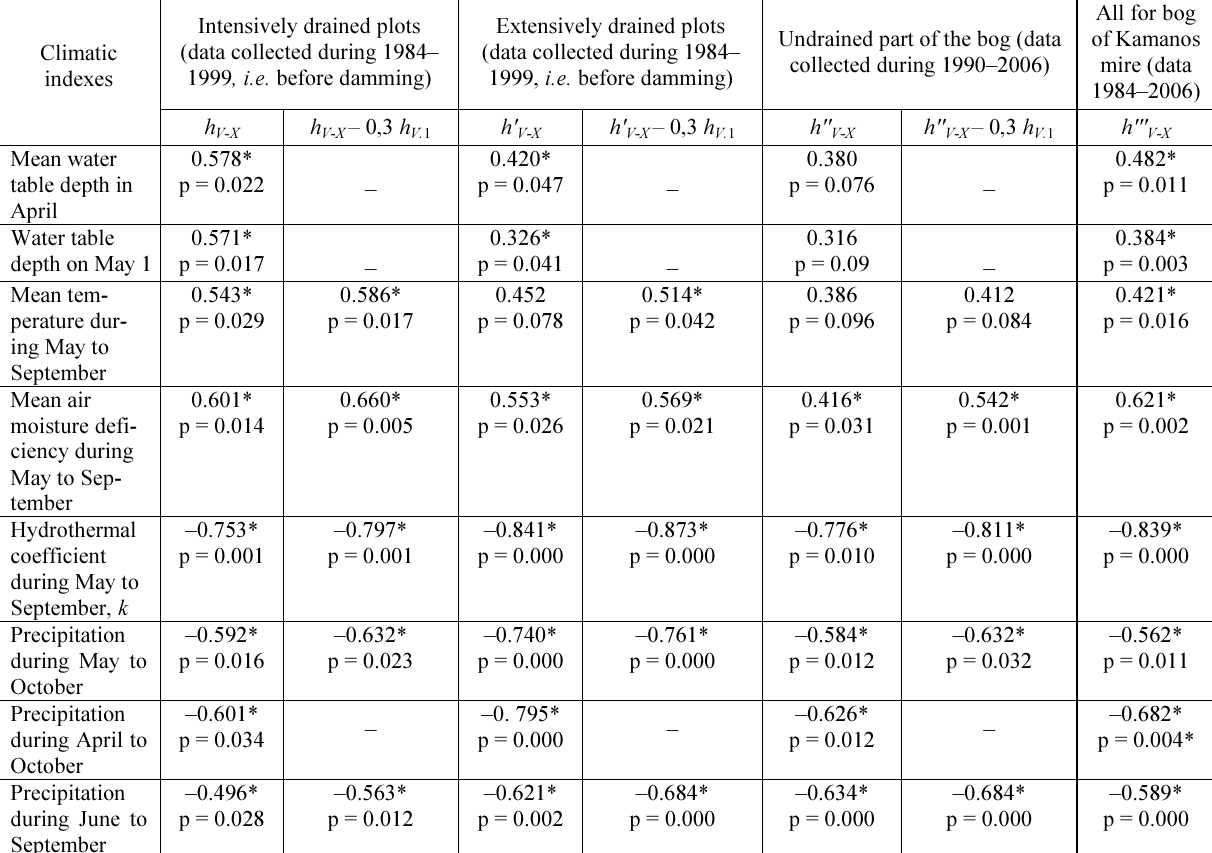
Table 1. Correlation coefficients between the climatic data and water table depth (h V-X ) during the growth period (V–X), which